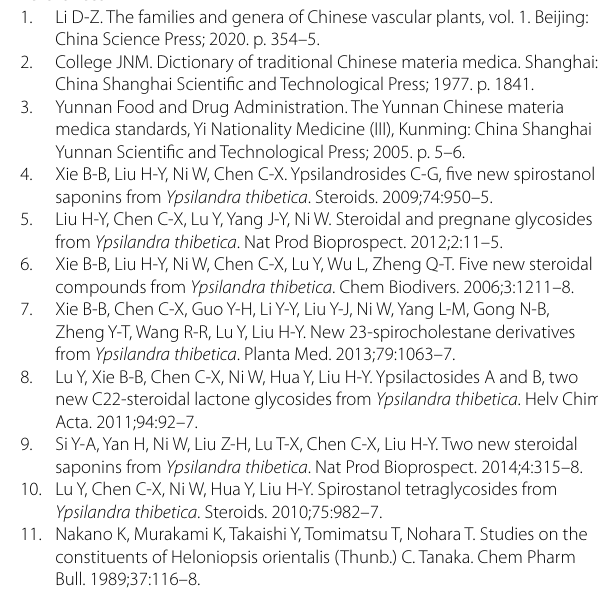
of compound 4 in pyridine‑ d 5 . Fig. S26. HMBC spectrum of compound 4 in pyridine‑ d 5 . Fig. S27. ROESY spectrum of compound 4 in pyridine‑ d 5 . Fig. S28. HRESI ( ) MS spectrum of compound 4 . Fig. S29. UV spectrum + of compound 4 . Fig. S30. 1 H NMR spectrum (600 MHz) of compound 5 in pyridine‑ d 5 . Fig. S31. 13 C NMR spectrum (150 MHz) of compound 5 in pyridine‑ d 5 . Fig. S32. 1 H– 1 H COSY spectrum of compound 5 in pyridine‑ d 5 . Fig. S33. HSQC spectrum of compound 5 in pyridine‑ d 5 . Fig. S34. HMBC spectrum of compound 5 in pyridine‑ d 5 . Fig. S35. ROESY spectrum of compound 5 in pyridine‑ d 5 . Fig. S36 . HRESI ( ) MS spectrum of com‑ + pound 5 . Fig. S37 . UV spectrum of compound 5